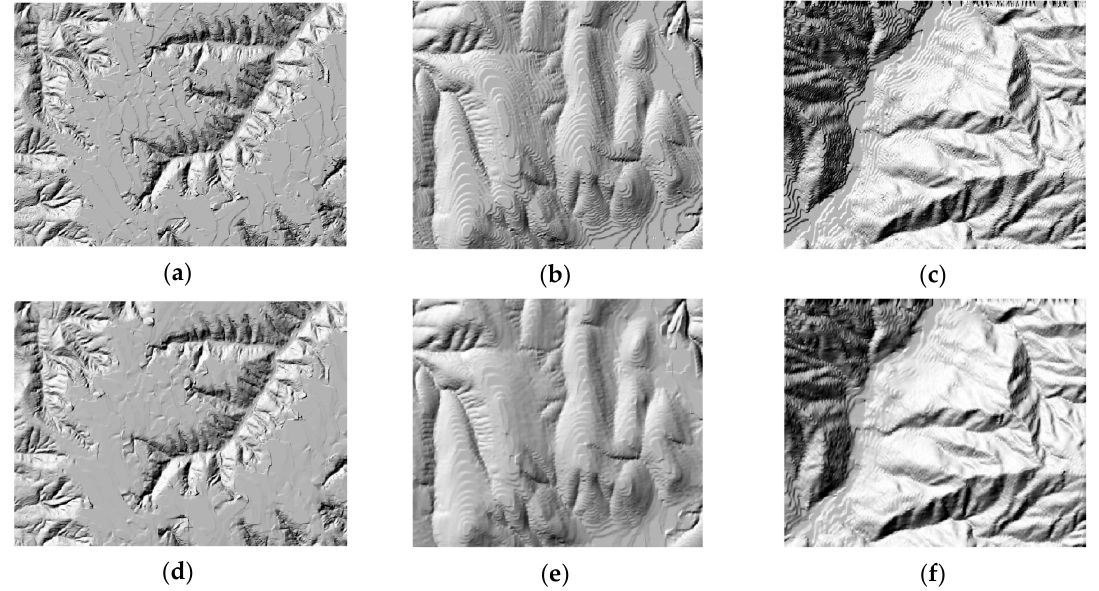
Figure 13. Hill-shading maps generated from DEMs for ( a ) DEM 5 of study area 1, ( b ) DEM 5 of study area 2, ( c ) DEM 5 of study area 3, ( d ) DEM 20 of study area 1, ( e ) DEM 20 of study area 2, and ( f ) DEM 20 of study area 3.